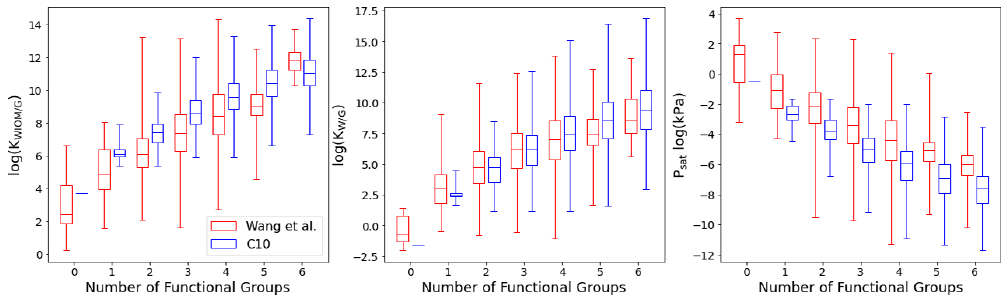
Figure 8. Box plot comparing C10 (in blue) with Wang’s dataset (in red) for K WIOM/G , K W/G , and P sat for different numbers of functional groups. Shown are the minimum, maximum, median, and first and third